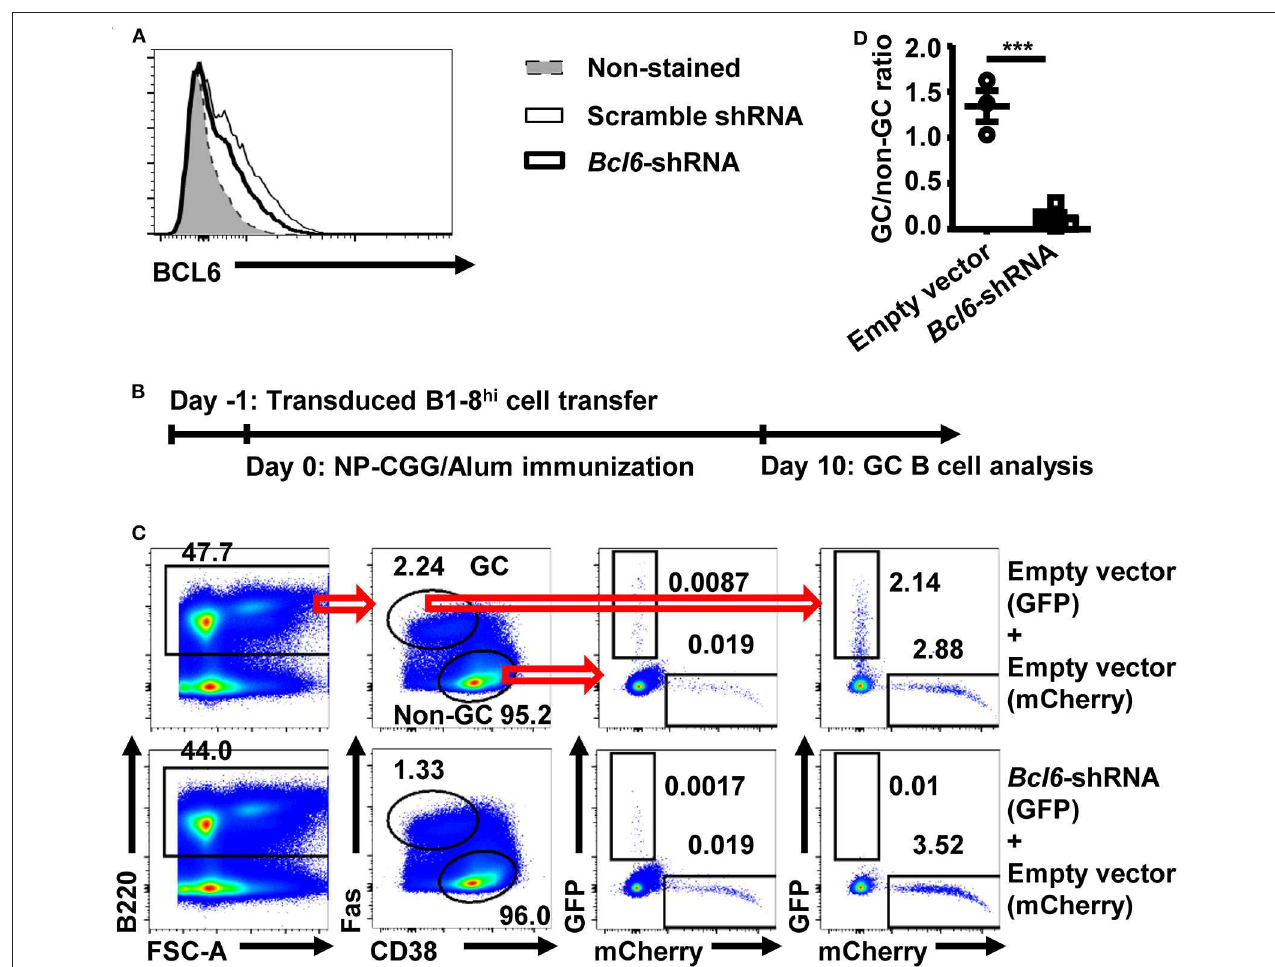
FIGURE 1 | Retrovirally transduced B1-8 hi cells can be used to study the shRNA function. (A) Representative flow cytometry profile showing the intranuclear BCL6 levels in untransduced A20 cells or transduced A20 cells with scramble shRNA or Bcl6 –shRNA retroviral vectors. Murine B cell lymphoma A20 cells were either untransduced or transduced with the indicated retroviral vectors and analyzed for intranuclear BCL6 levels by flow cytometry 3 days later. (B) B1-8 hi cell transfer model for evaluating germinal center (GC) B cell differentiation. Fresh or retrovirally transduced B1-8 hi cells were adoptively transferred to wild-type (WT) recipients on day − 1, immunized with NP-CGG/Alum on day 0, and analyzed for GC B cell differentiation on day 10. (C,D) Representative flow cytometry profiles (C) showing the percentages of empty vector and Bcl6 –shRNA transduced B1-8 hi cells (expressing a GFP reporter) as well as the co-transferred empty vector transduced B1-8 hi cells (expressing a mCherry reporter) in non-GC B cells and GC B cells, and representative graph (D) showing the GC/non-GC ratios of percentages of transduced B1-8 hi cells (expressing GFP) normalized to empty vector transduced cells (expressing mCherry). The empty vector or Bcl6 –shRNA transduced B1-8 hi cells (expressing GFP) were mixed 1:1 with empty vector transduced B1-8 hi cells (expressing mCherry) and adoptively transferred into WT recipient mice and evaluated for their percentages among non-GC B cells and GC B cells (C) 10 days after NP-CGG/Alum immunization. The ratio of the percentage of empty vector or Bcl6 –shRNA transduced cells (expressing GFP) in GC B cells to that in the matched non-GC B cells was calculated and normalized to the ratio of empty vector transduced cells (expressing mCherry), expressed as GC/non-GC ratio (D) . Each symbol in (D) represents data from an individual mouse. The bars represent mean ± SEM; *** p ≤ 0.001, unpaired two-tailed t -test. A representative of two independent experiments is shown.